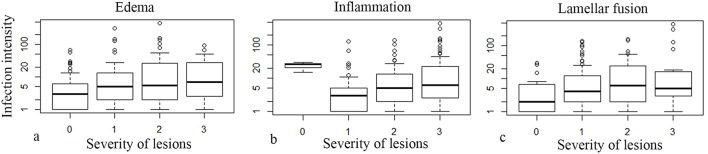
Box Plots of severity of pathological lesions (edema, infiltration, lamellar fusion) and number of cysts per gill arch (infection intensity) (note the logarithmic scale in the y axis).